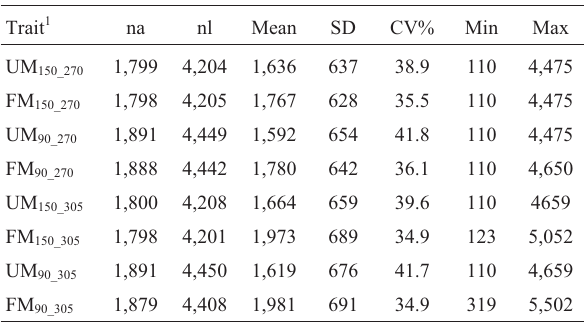
Table 1 - Number of animals (na) and lactations (nl), mean (kg), standard deviation (SD), variation coefficient (CV%) and minimum (Min) and maximum (Max) values for each